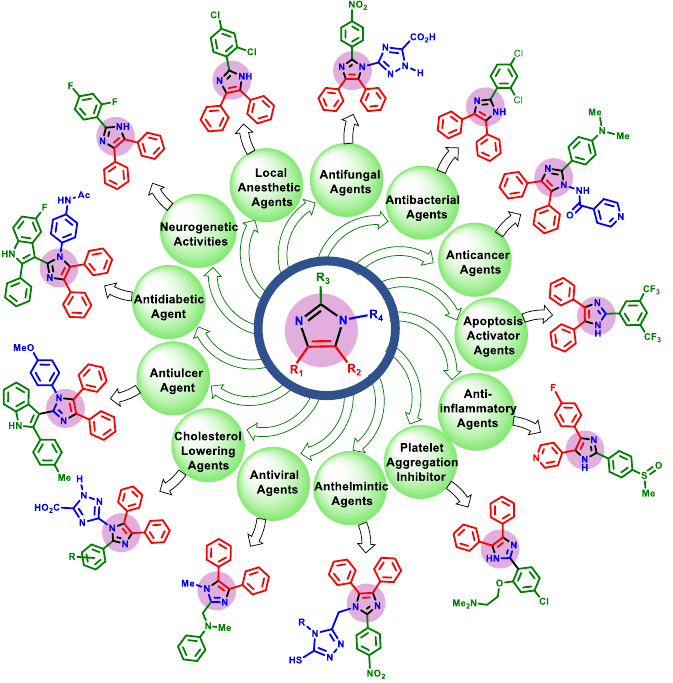
Figure 1. Schematic presentation of some biologically important 2,4,5-trisubstituted imidazole containing heterocyclic compounds having therapeutic applications.